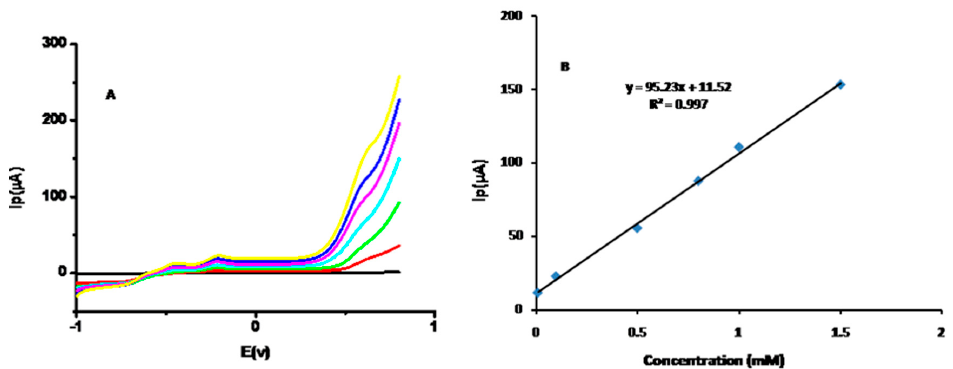
Figure 7. ( A ) Square wave voltammograms for different glucose concentrations: 0.01 mM, 0.1 mM, 0.5 mM, 0.8 mM, 1 mM and 1.5 mM; ( B ) A calibration plot of Ip versus glucose concentration.